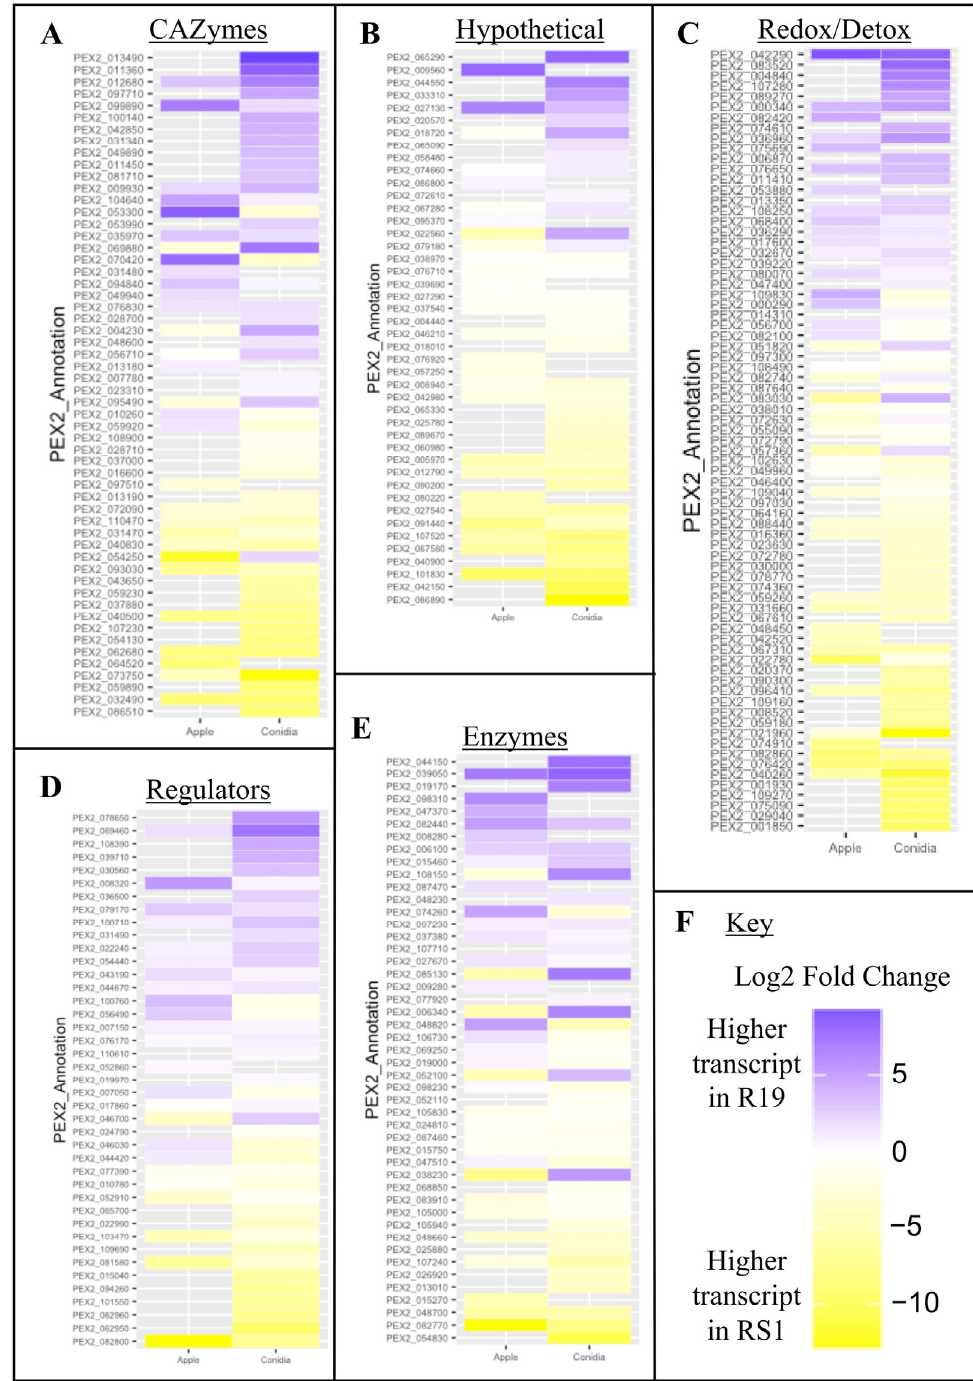
Figure 7. Heat maps showing differentially expressed genes encoding known or predicted virulence factors across ungerminated spores and ramifying hyphae and mycelium from decayed apple fruit from highly virulent (R19— Penicillium expansum ) and weakly aggressive strains (RS1— P. polonicum ). Genes previously identified as virulence factors depicted with annotations (PEX2_Annotation) and sorted into ( A ) CAZymes; ( B ) hypothetical proteins and genes with unknown function; ( C ) redox and detoxification-related genes; ( D ) regulators, including transcription factors; and ( E ) enzymes. ( F ) Key to heat map: colors represent log 2 fold change between the R19 and RS1 samples, with blue showing higher expression in R19 samples and the yellow showing higher expression in RS1. The left ‐ side columns show the log 2 fold change between ramifying hyphae and mycelium from apple while the right ‐ side columns show the log 2 fold change between ungerminated conidia.